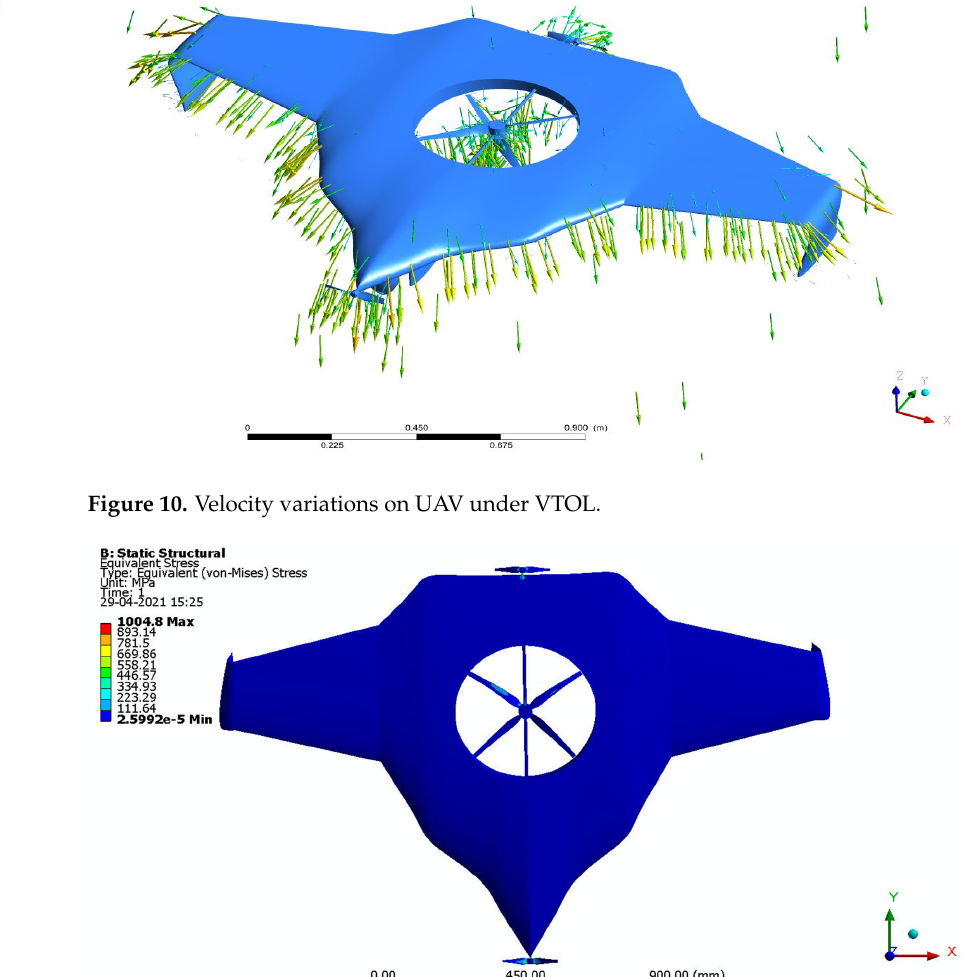
Figure 12. Total deformation. In forward speed operation, the maximum stresses and total deformation occurred at the root of the propellers and landing gear of the UAV. After the successful completion of forwarding speed, the VTOL operation was computed, wherein the major impacted region of the UAV was higher in VTOL. There- fore, the structural outcome was more crucial than other manoeuvrings, so utmost care was given to this investigation. The CFRP-woven-wet-based composite and GFRP-S- UD-based lightweight material performed better than other lightweight materials. Fig- ures 11 and 12 belong to CFRP’s structural outcomes, and Figures 13 and 14 belong to GFRP’s structural outcomes. As mentioned earlier, two different grid convergence tests were conducted on the induced velocity of the Version I UAV and equivalent stress of the Version II UAV. Figure 13 reflects the comparative analysis of grid convergences test I, wherein the grid convergence conduced on the induced velocity variations while the